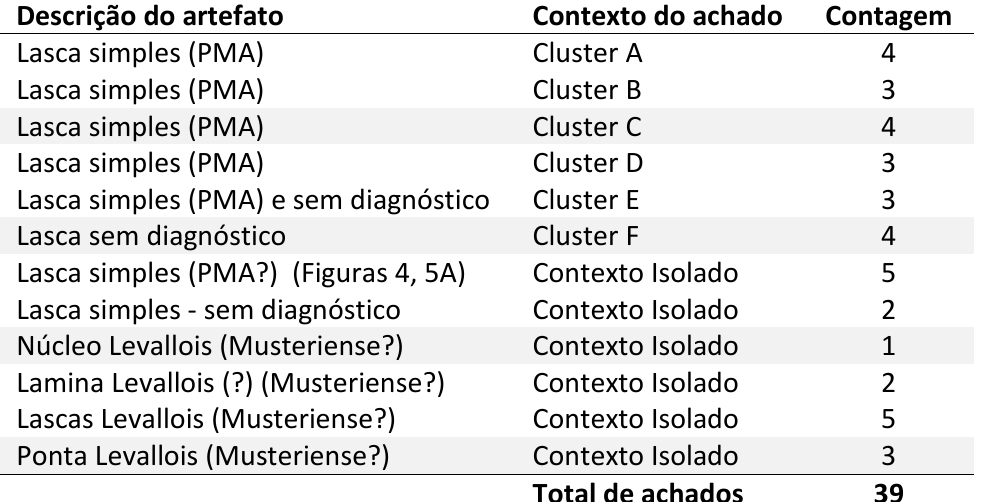
Table 1. Archaeological finds in Cafema, Namibia-Angola (Nicoll 2010). ”?” indicates